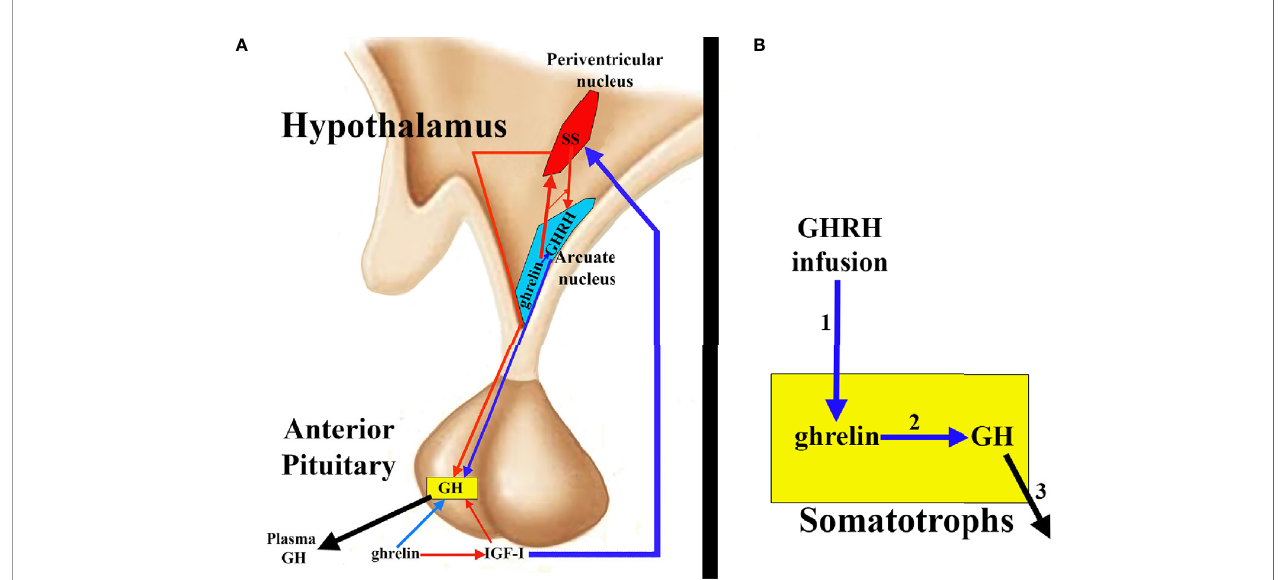
FIGURE 4 | Ghrelin and pituitary GH secretion. (A) Ghrelin directly stimulates pituitary GH secretion (blue arrow), but indirectly it also contributes to this secretion, since ghrelin inhibits IGF-I (red arrow) and, therefore, the inhibitory effect of this peptide on GH; furthermore, the inhibition of IGF-I impedes the stimulatory effect of this hormone on the hypothalamic release of SS (blue arrow), which allows the release of GHRH to the portal circulation (blue arrow) with its consequent positive effect on the synthesis and secretion of GH. Furthermore, it appears that ghrelin co-localizes with GHRH in the hypothalamic arcuate nucleus, inducing its release, directly or inhibiting the release of SS from the periventricular nucleus (red arrow), thus inhibiting the inhibitory effect that SS exerts on the release of GHRH and on the synthesis and secretion of pituitary GH. (B) ghrelin and its receptor are expressed in the pituitary, where they could play an auto/paracrine role in the regulation of GH release. In fact, GHRH infusion (1) increases pituitary ghrelin mRNA levels that could induce GH stimulation (2) and release